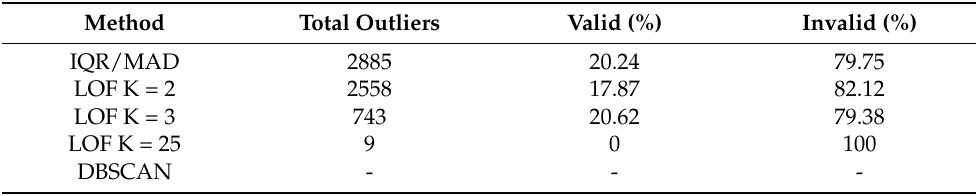
Table 5. Number of valid/invalid outliers detected using the implemented scoring method for Marasti Students Campus